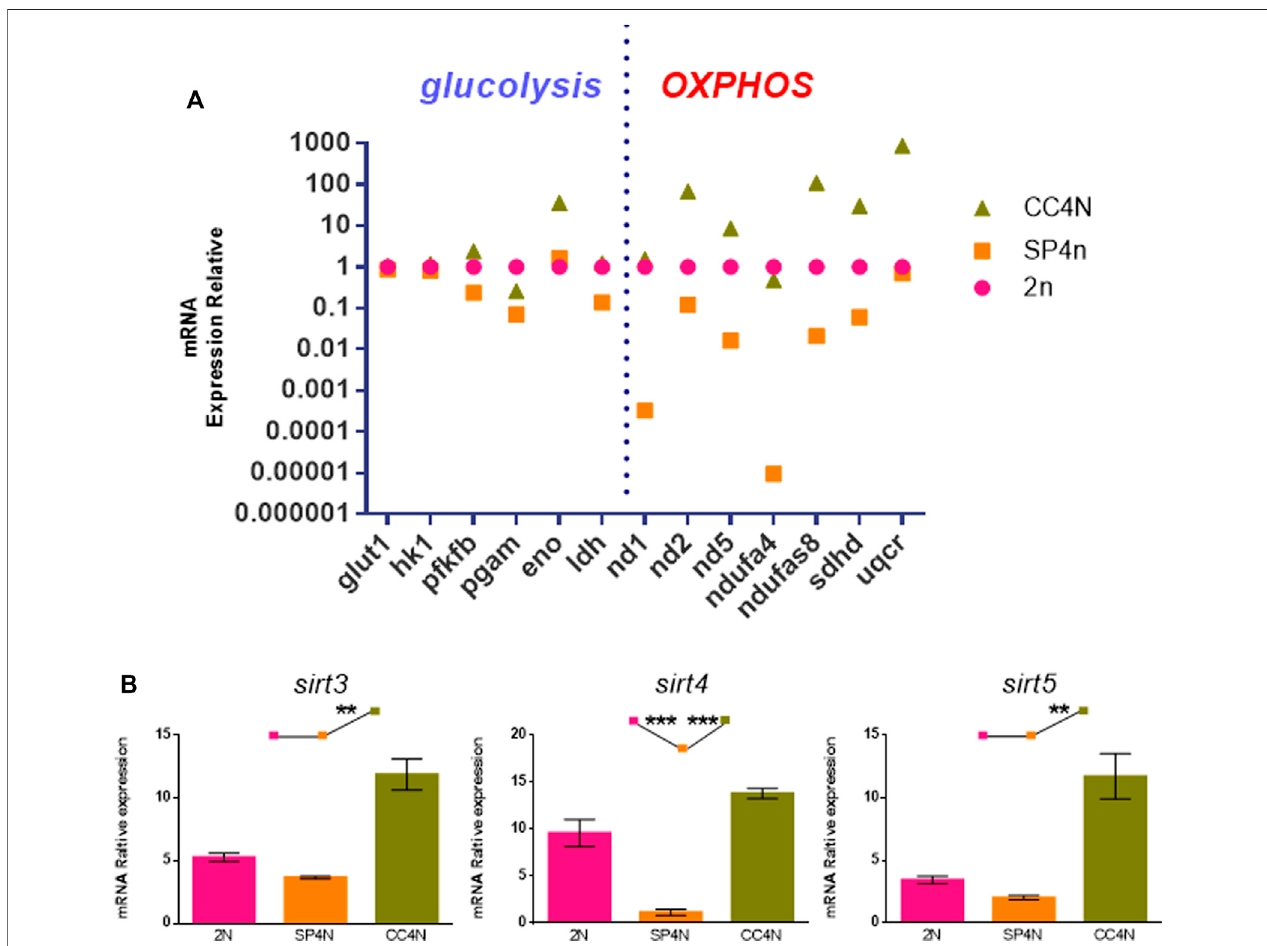
FIGURE 6 | Transcriptional levels related to energy metabolism were detected in the SP600125 induced tetraploid cells (SP4N cells), the tetraploid cells from C. auratus × C. carpio L. (CC4N cells) and the diploid fi sh cells (2N cells). (A) Comparison of transcription levels of glycolysis and oxidative phosphorylation (OXPHOS) related genes in the three types of cells. (B) The transcriptional expression levels of sirt genes detected by qRT-PCR. For each sample, experiments were repeated at least 3 times.